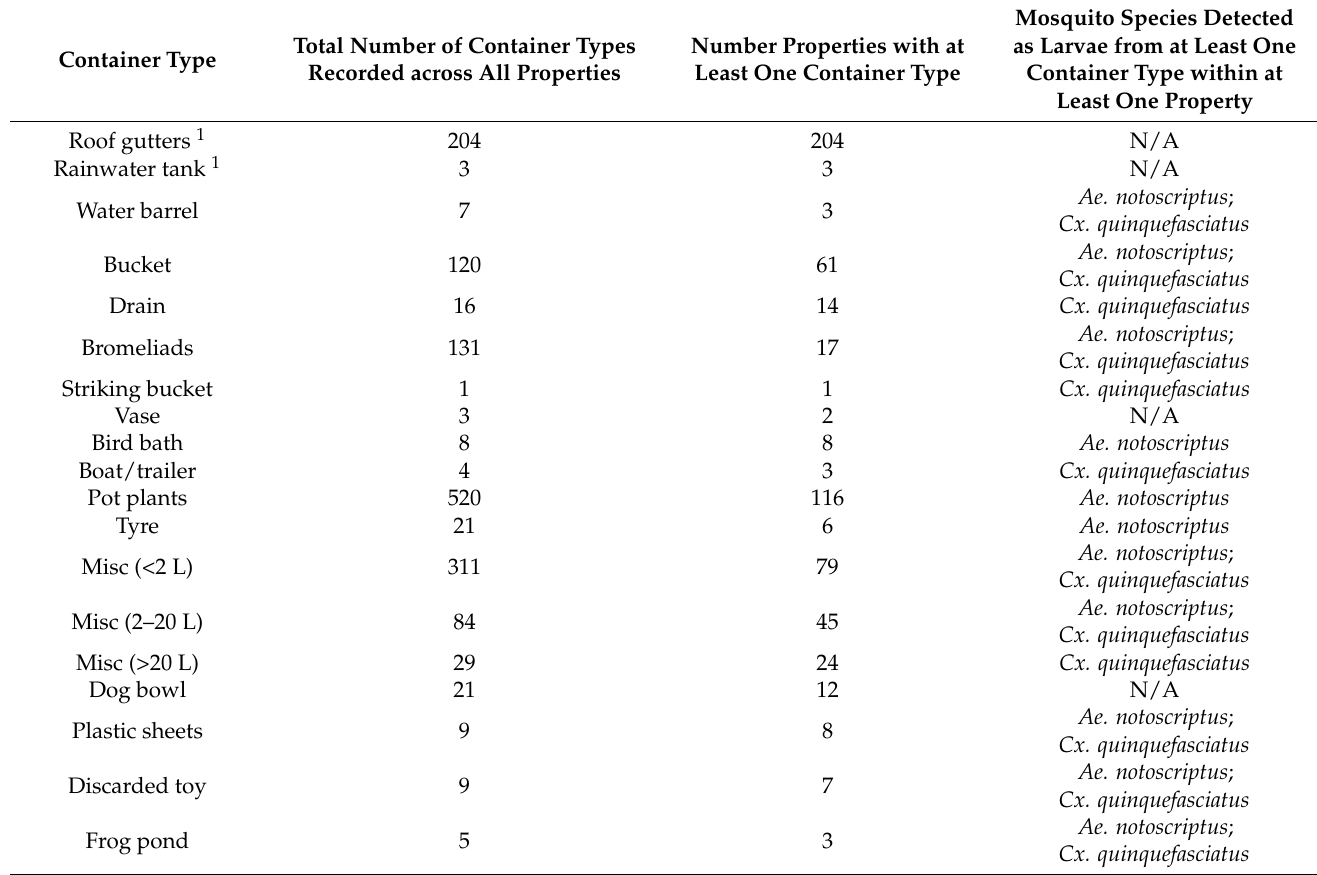
Table 1. A summary of container types and mosquito species detected in the surveys of 337 properties in Carrington, Newcastle, March